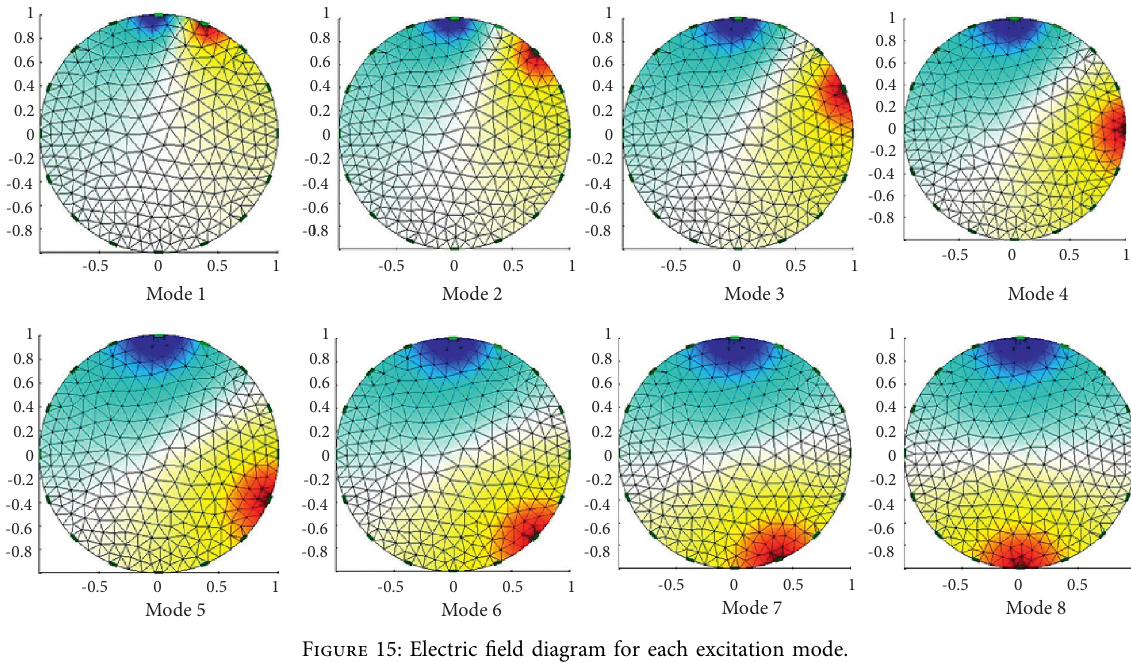
Figure 15: Electric field diagram for each excitation